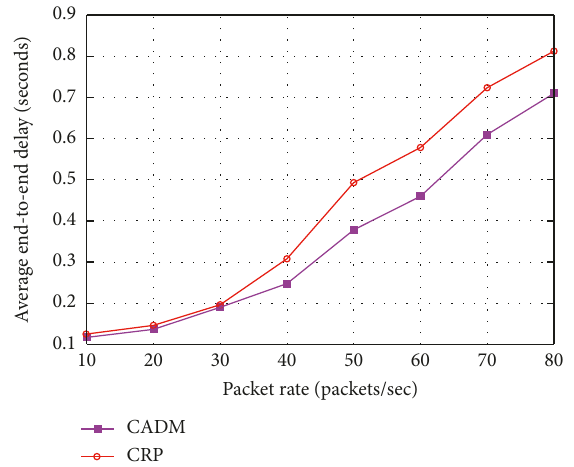
Figure 5: Average end-to-end delay with varying packet